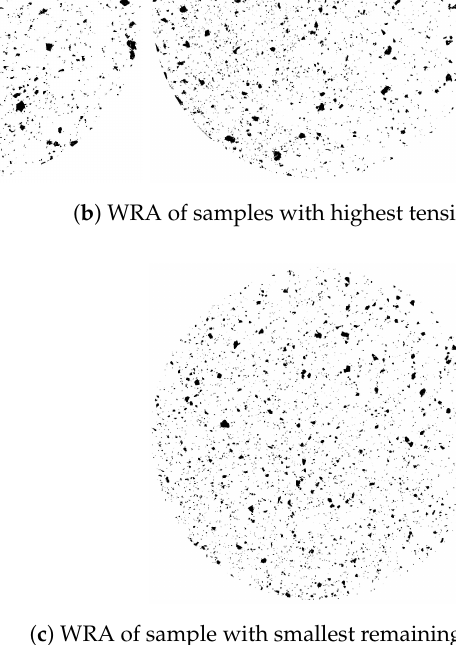
Figure 10. Comparison of remaining particle size distribution by WRA related to decrease in cross-link density and tensile strength. The diameter of the samples is